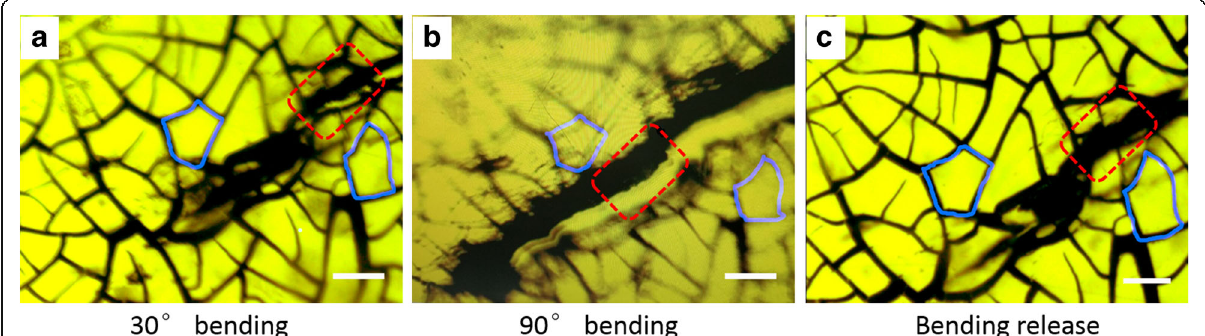
Fig. 5 Working mechanism of the SAN sensor at different stages: a 30° bending, b 90° bending, and c bending release. Scale bars in figures are 50 μ